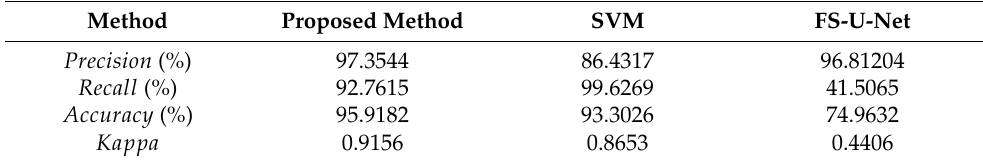
Figure 24. Details of the paddy rice mapping results of different methods: ( a1 – c1 ) false-color image of the temporal features of frame 62-4; ( a2 – c2 ) paddy rice mapping result of the proposed method; ( a3 – c3 ) paddy rice mapping result of the SVM classifier; ( a4 – c4 ) paddy rice mapping result of the FS-U-Net method. Table 6. Paddy rice mapping accuracies of frame